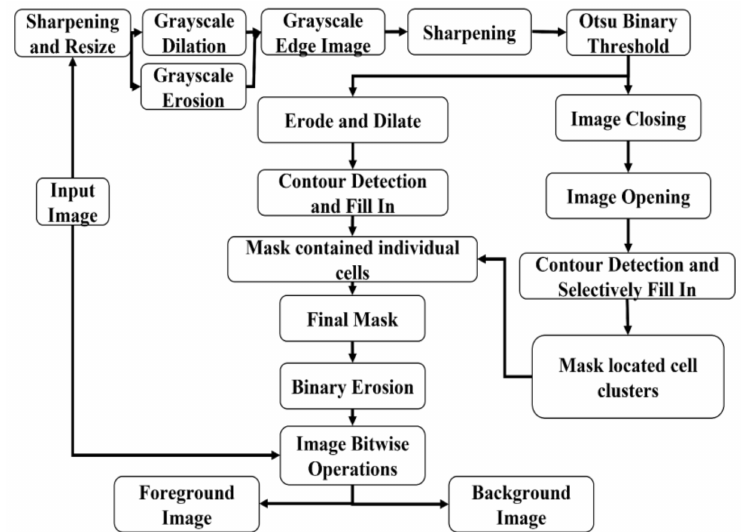
Figure 1. The flowchart of the proposed